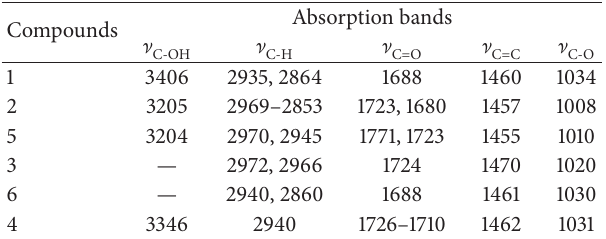
Table 1: Interpretation of FT-IR spectrum of oleanane-derived